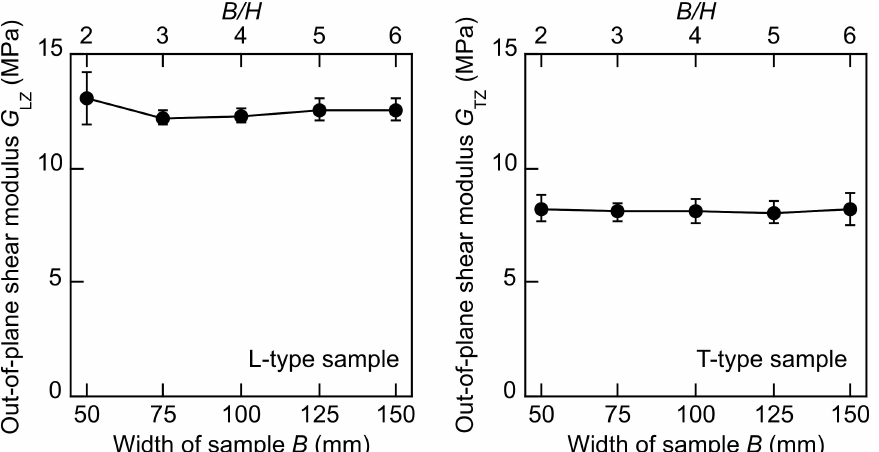
Figure 5. G LZ – B, G LZ – B/H , G TZ – B , and G TZ – B/H relations obtained from the torsional vibration tests. Results = average ± standard